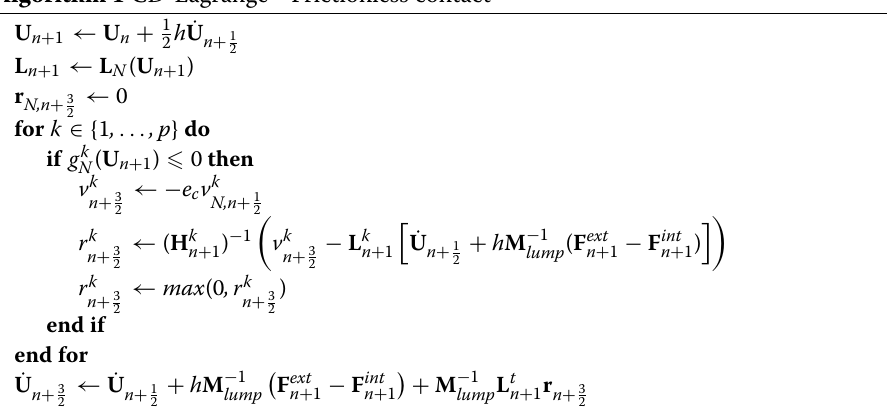
Algorithm 1 CD-Lagrange—Frictionless